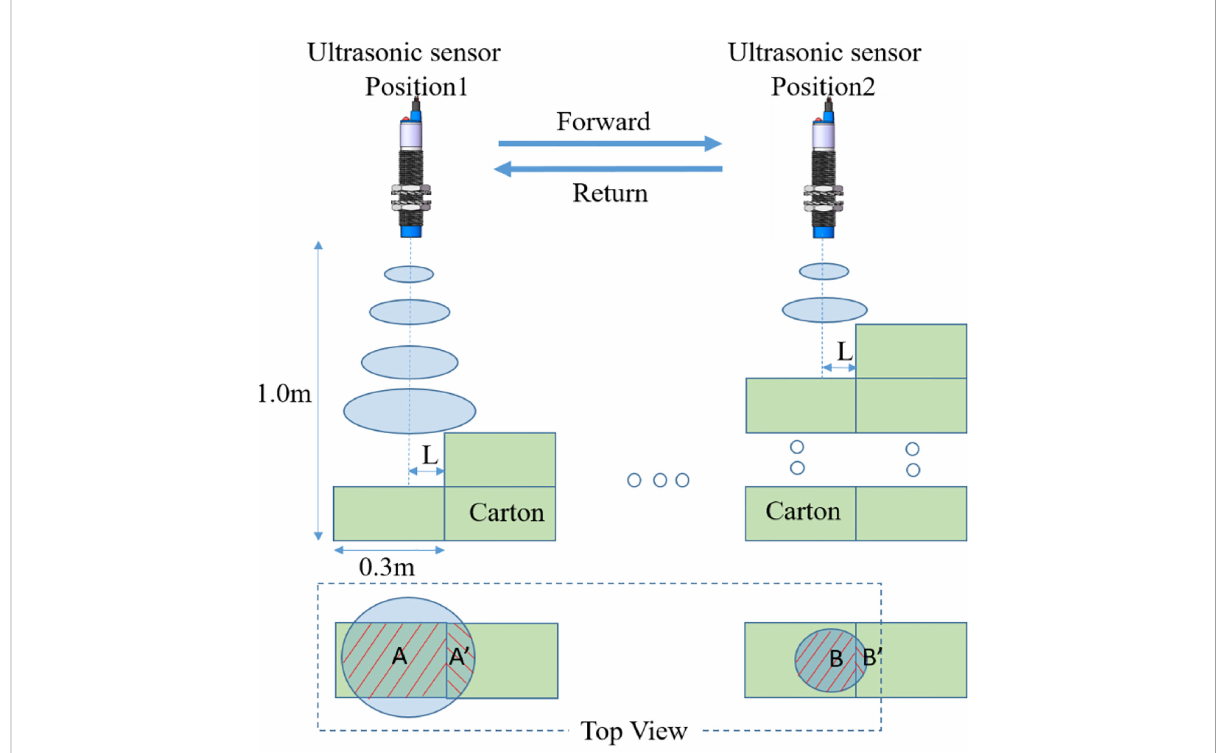
FIGURE 13 Ultrasonic cone. The quasi-static test ignores the in fl uence of velocity and the detection area changes due to the change of detection distance, and the detection area affects the measured value at the step